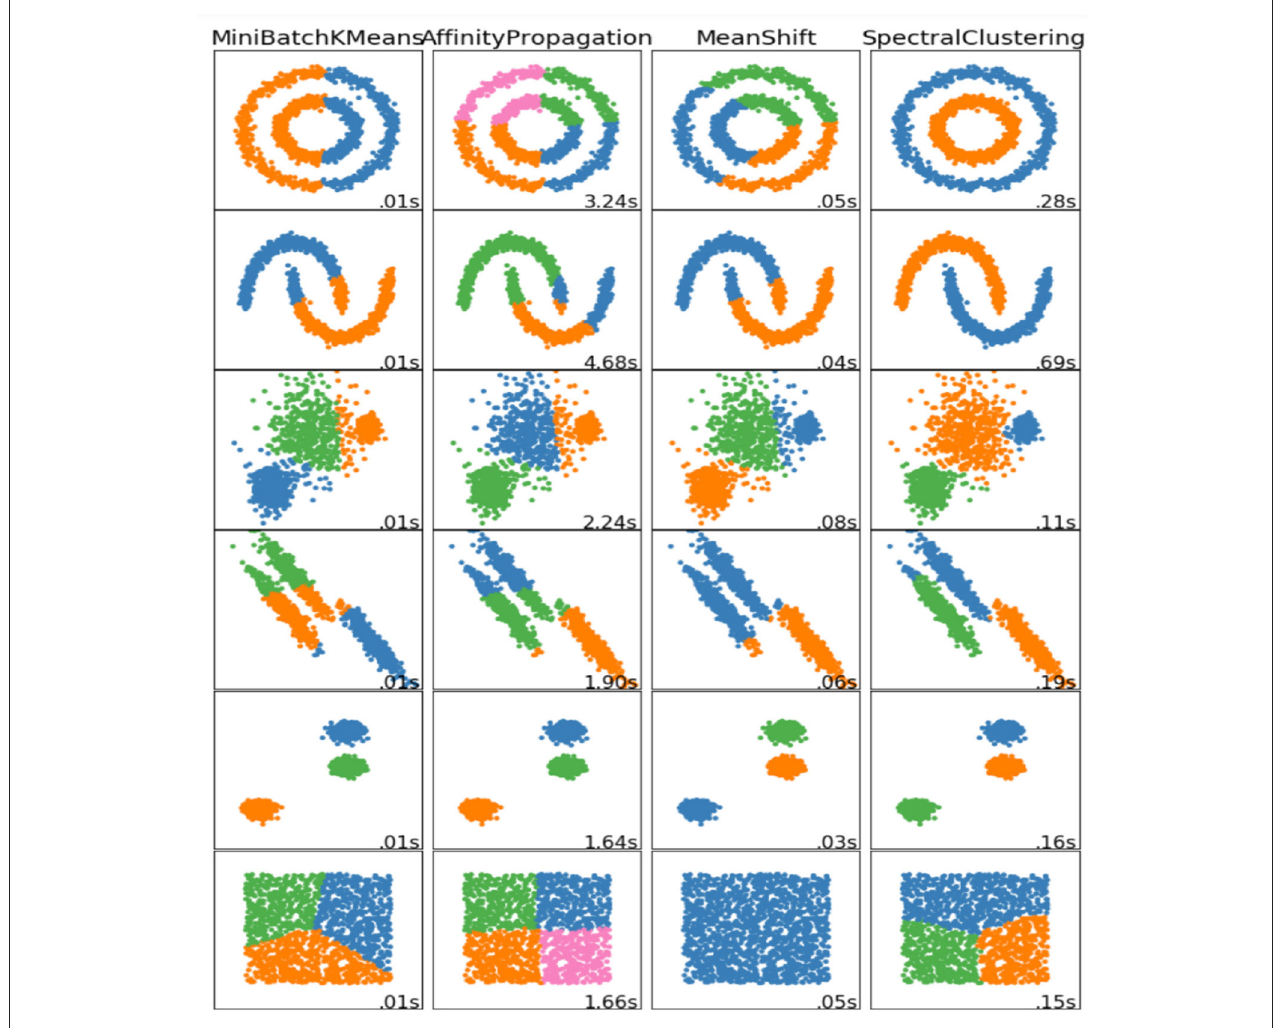
FIGURE 5 | Some non-linear data sets and some ways to cluster them [37].